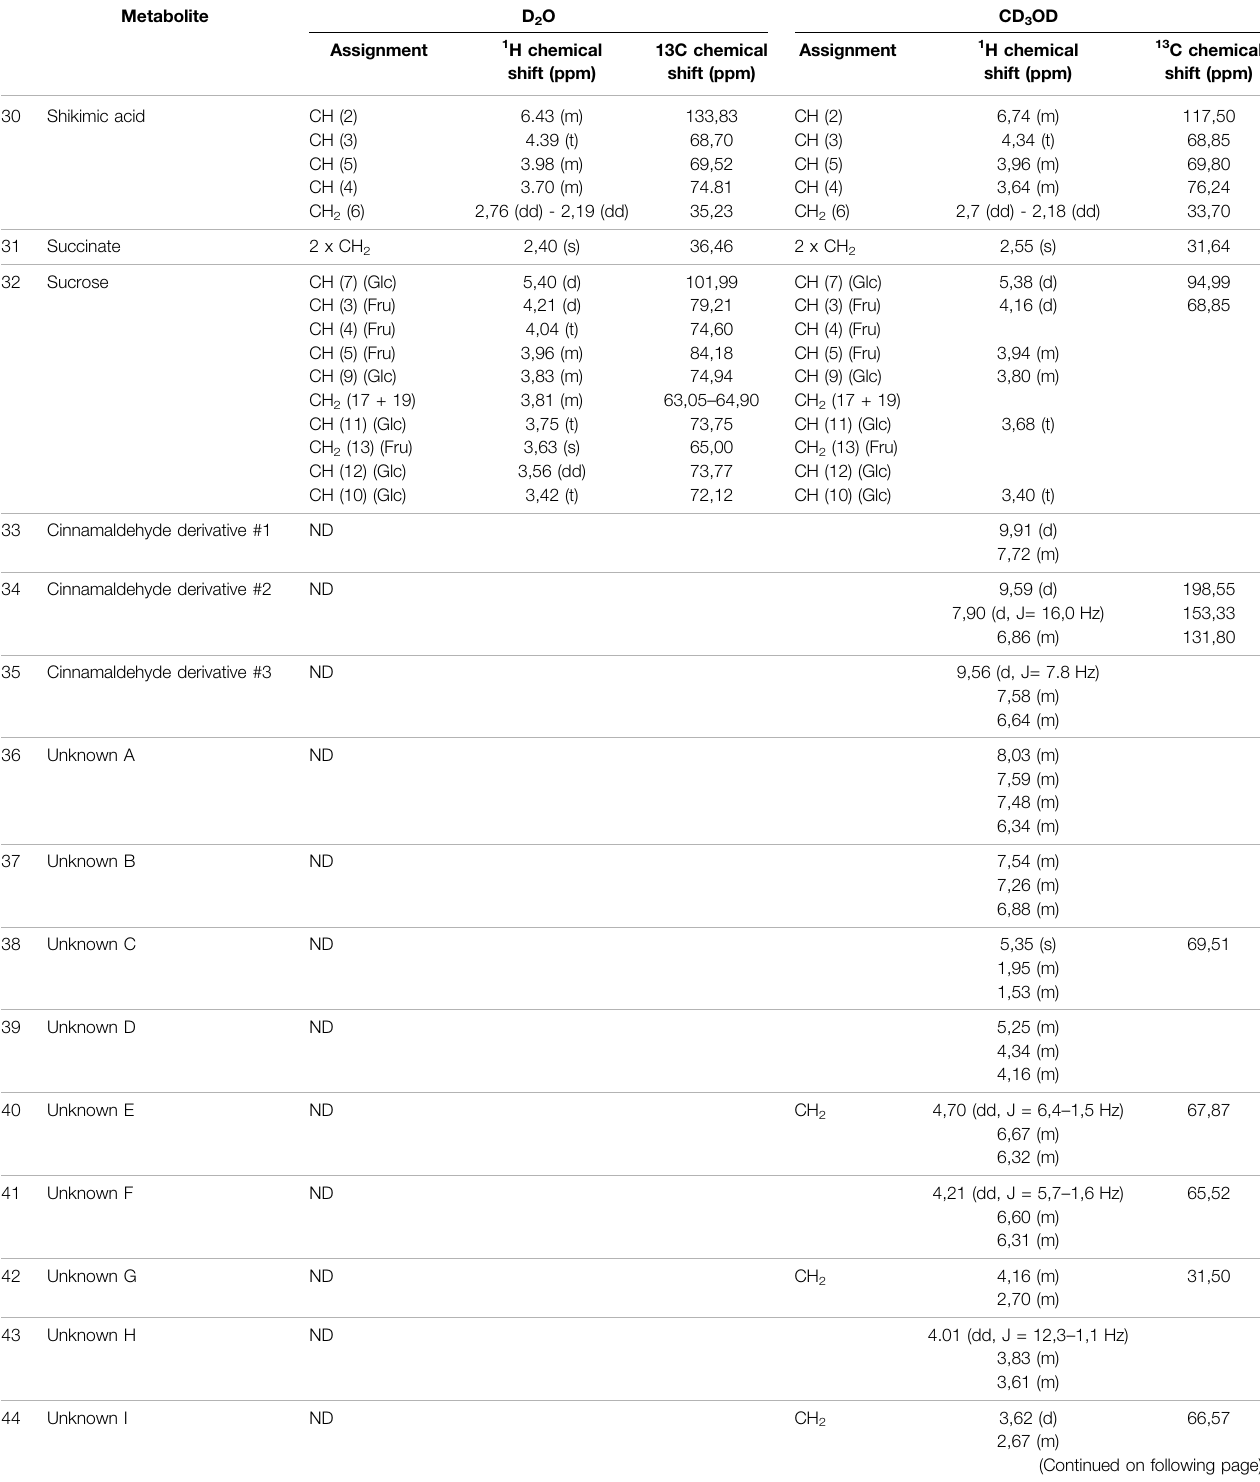
TABLE1| ( Continued )Assignmentsof 1 Hand13Cchemicalshiftsoftheresonancesofmetabolitescontainedincinnamonextractsasfoundin 1 H-NMR, 1 H, 1 H-TOCSY, and 1 H, 13 C-HSQC spectra of samples dissolved in D 2 O and CD 3 OD. ND (not detected) indicates that the resonances of the metabolites were not found in the 1 H-NMR spectrum of the sample. Missing values of chemical shifts are due to overlapped resonances or signals with too low